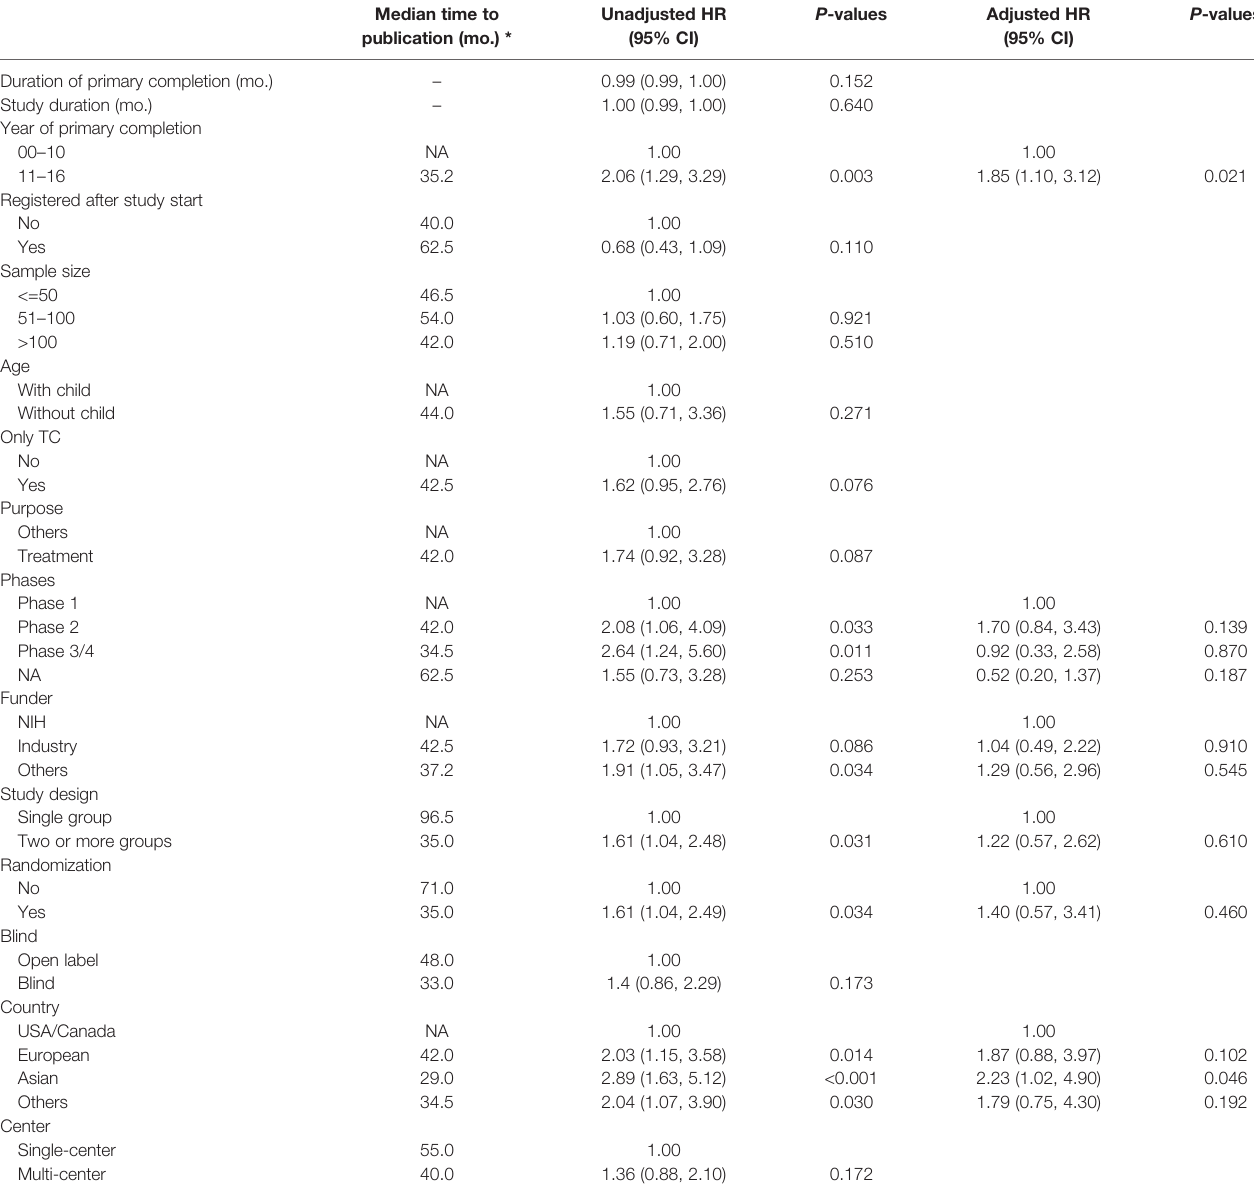
Median time to publication (mo.) *